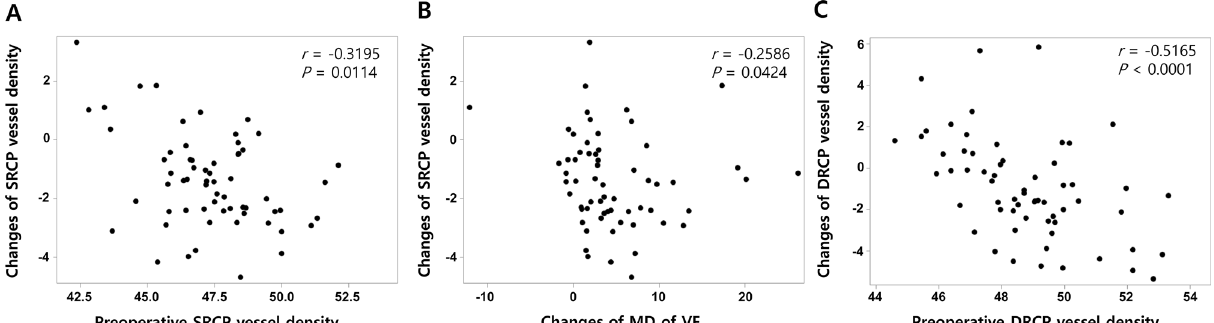
Figure 2. Scatterplots showing significant associations between vessel density changes and preoperative vessel denstiy and VF changes in patients with chiasmal compression. ( A ) Negative correlation between vessel density changes in the superficial retinal capillary plexus (SRCP) pre- and postoperatively and preoperative SRCP vessel density in patients with chiasmal compression ( r = − 0.3195, P = 0.0114); ( B ) negative correlation between vessel density changes in the SRCP and changes in the mean deviation of the visual field pre- and postoperatively ( r = − 0.2586, P = 0.0424); ( C ) negative correlation between vessel density changes in the deep retinal capillary plexus (DRCP) pre- and postoperatively and preoperative DRCP vessel density ( r = − 0.5165, P < 0.0001).